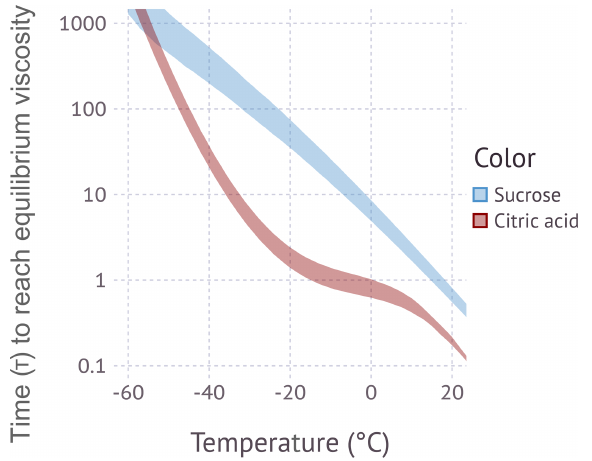
Figure 6. Time to reach equilibrium viscosity along the viscosity isopleth shown in Fig. 5. The shading corresponds to the range of 5 × 10 6 to 4 . 8 × 10 7 Pas (sucrose, blue-shaded area) and 5 × 10 6 to 3 . 8 × 10 7 Pas (citric acid, red-shaded